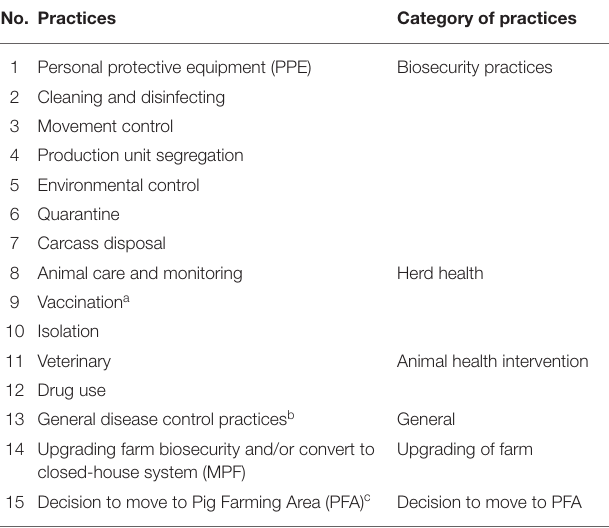
TABLE 2 | Disease prevention and control practices identified from the interviews (10 small-medium-scale farms, 2 large-scale farms). No.